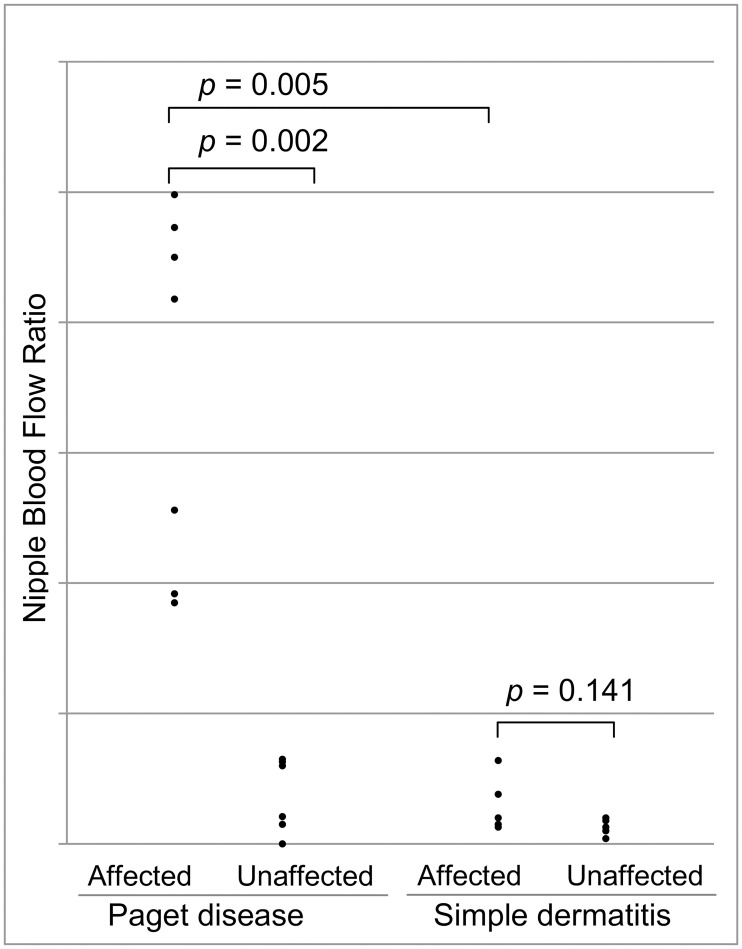
Comparison of nipple blood flow ratios between the affected and unaffected nipples with each condition.